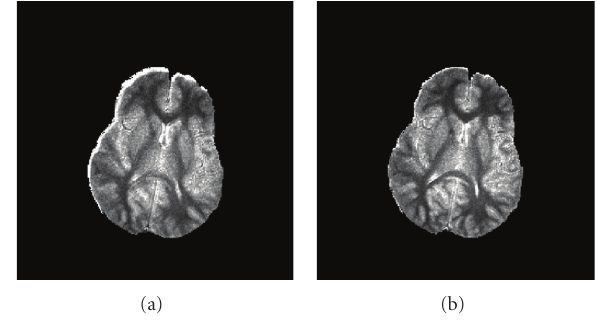
Figure 4: JSR technique: two active contours evolve in two flip angle images (of angles 5 ◦ and 40 ◦ ) to jointly register and segment (generate the brain mask) the brain. The region outside the mask are brightened to better show the contrast.